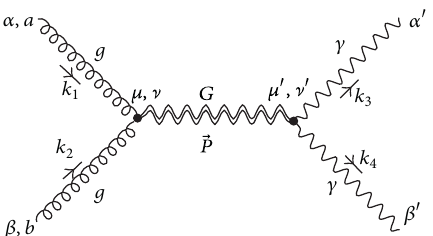
Figure 3: The subprocess Feynman diagram for diphoton produc-